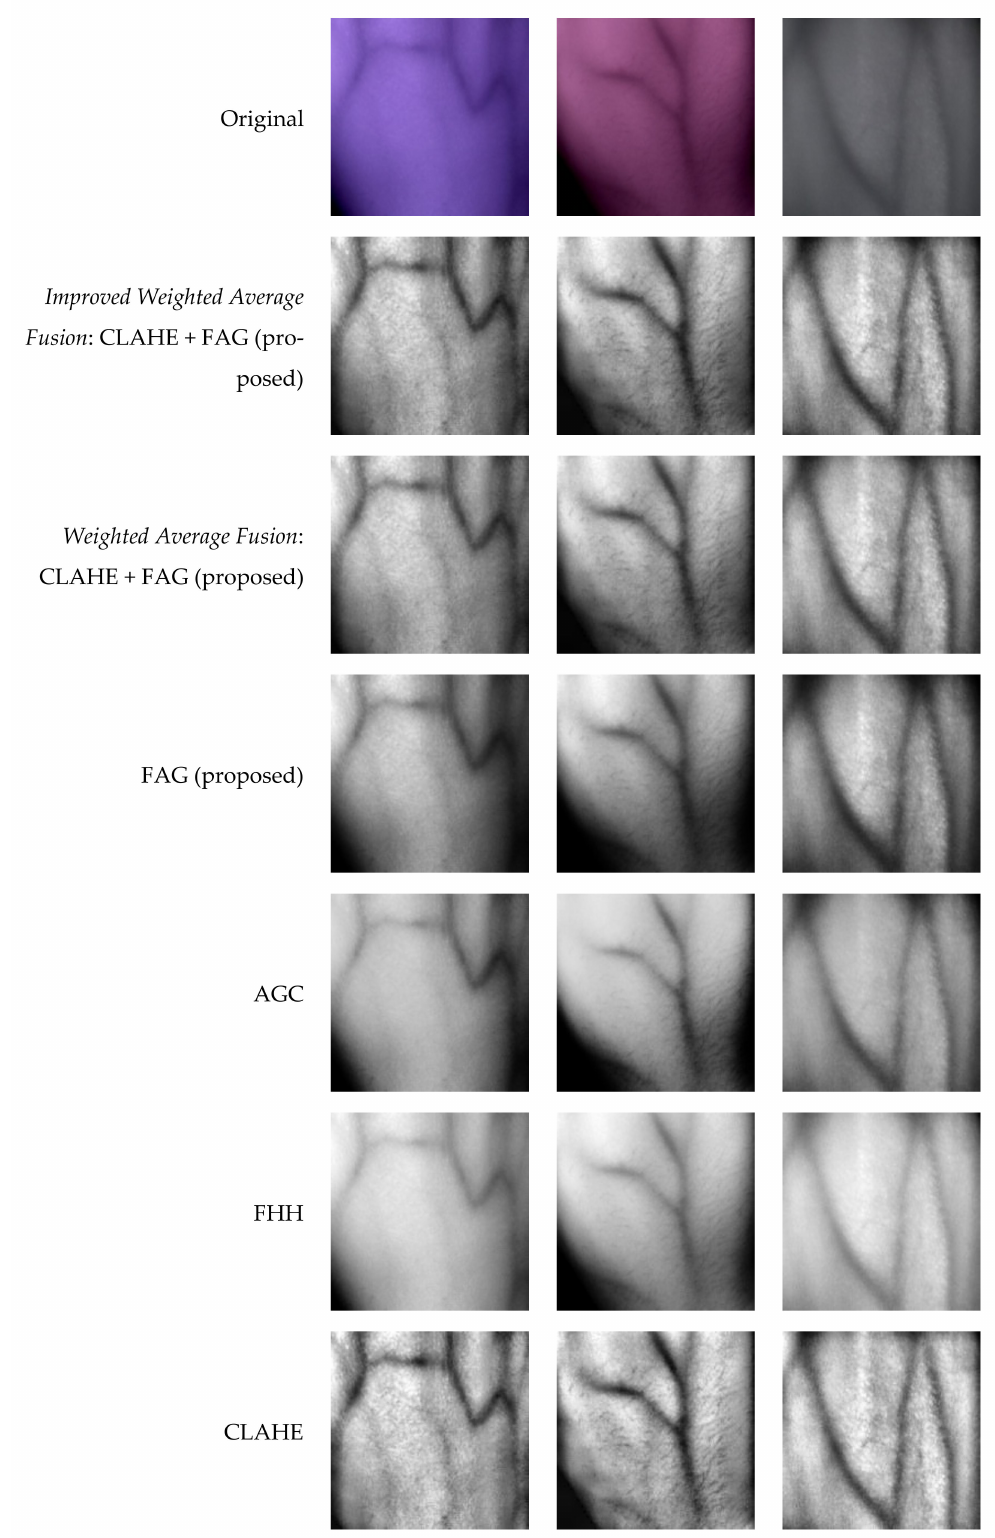
Figure 9. Sample results of various vein enhancement techniques based on three images from the SUAS